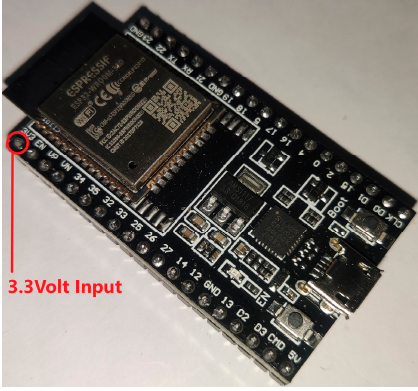
Figure 3. ESP32 Development Board.